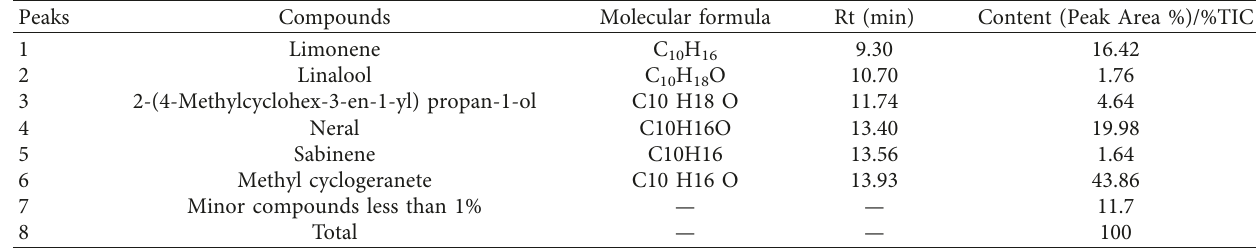
Table 1: Chemical composition of the oil of Dracocephalum polychaetum